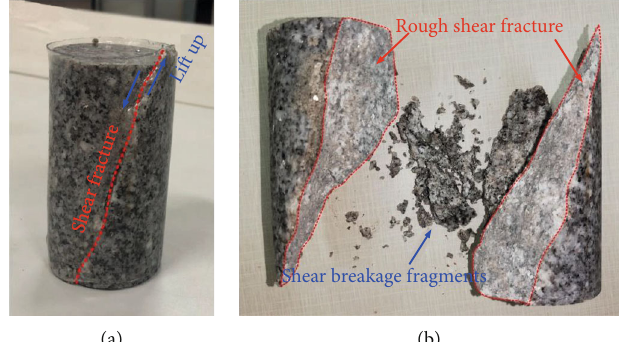
Figure 16: Picture of (a) fractured granite after seepage test and (b) rupture characteristics of fractures inside the